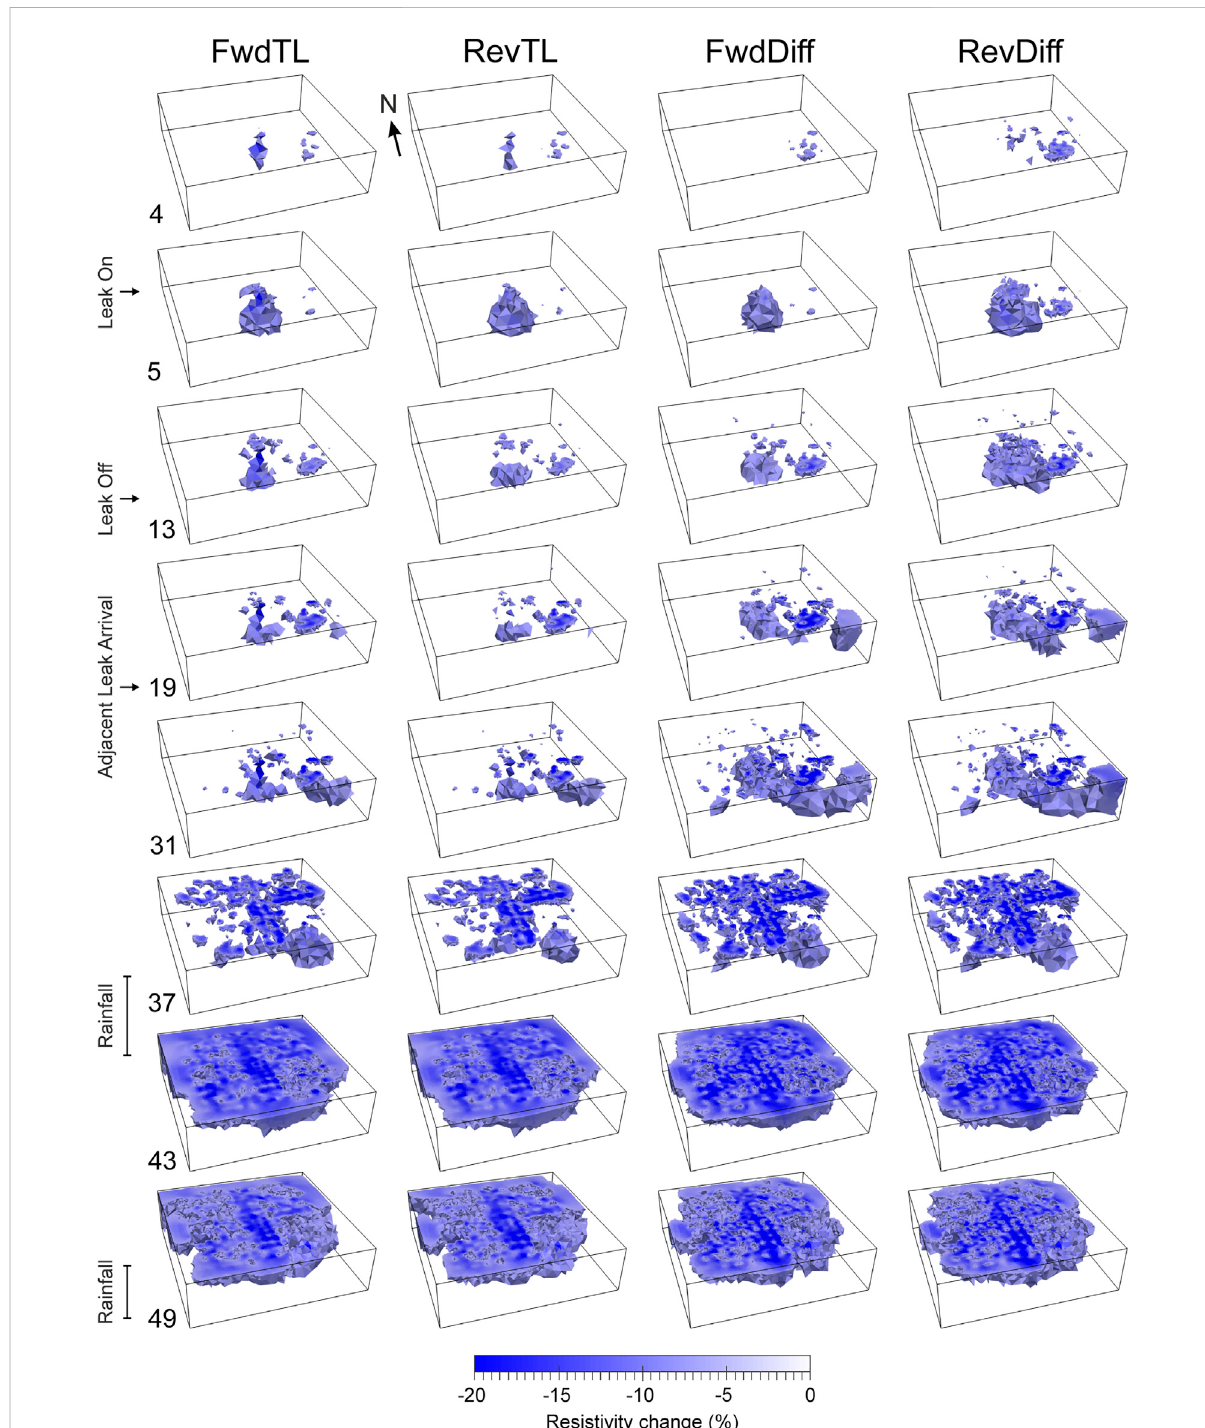
FIGURE 13 Distributionsof fractional resistivity change at Site 3 for theforward and reverse time-lapse and difference inversions atthe timesteps indicated on the left-hand side. Only model cells with resistivity changes below -20% are shown.